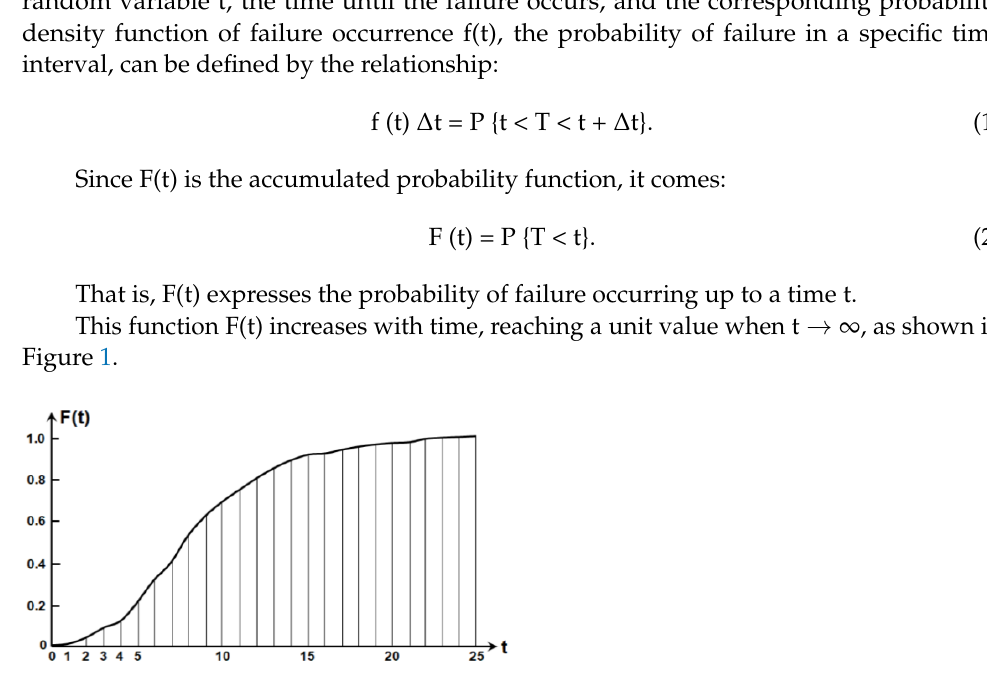
Figure 1. Probability density function F(t).